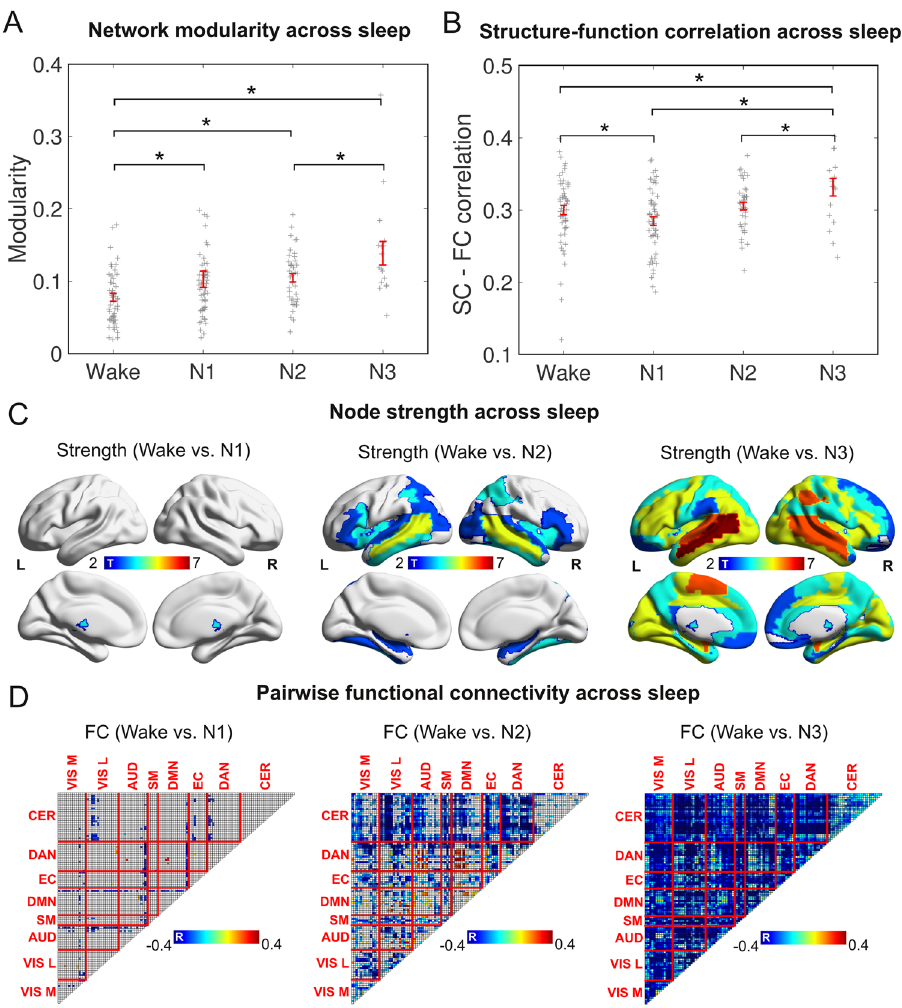
Figure 5. Characterization of functional connectivity during wakefulness vs. NREM sleep. ( A ) Network modularity (extent of division of the network into sub-networks) for wakefulness, N1, N2 and N3 sleep (mean ± SEM, points are values for each participant, * p < 0.05, FDR corrected). ( B ) Correlation between structural connectivity (SC) and functional connectivity (FC) for wakefulness, N1, N3 and N3 sleep (mean ± SEM, points are values for each participant, * p < 0.05, FDR corrected). ( C ) Anatomical overlay of the AAL regions presenting decreased node strength (sum of weights attached to links belonging to a node) in N1, N2 and N3 sleep vs. wakefulness (p < 0.05, FDR corrected). ( D ) Differences in pairwise connectivity between wakefulness and N1, N2, N3 sleep. Resting state network abbreviations are as follows. VIS M: medial visual, VIS L: visual lateral, AUD: auditory, SM: sensorimotor, DMN: default mode, EC: executive control, DAN: dorsal attention, CER: